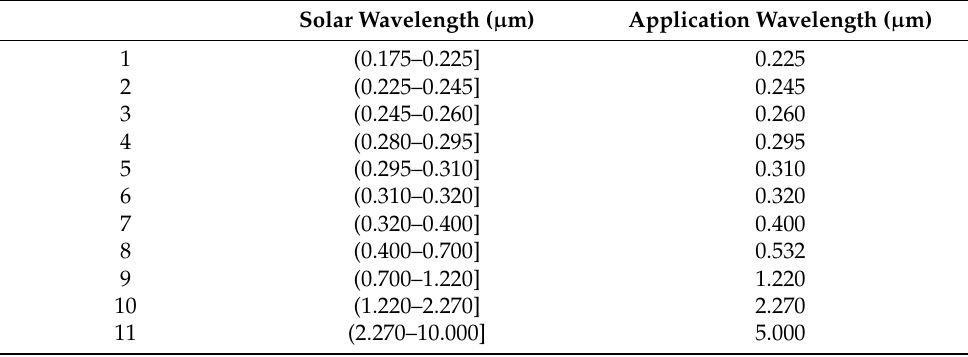
Table 1. Wavelength distribution in the radiative transfer